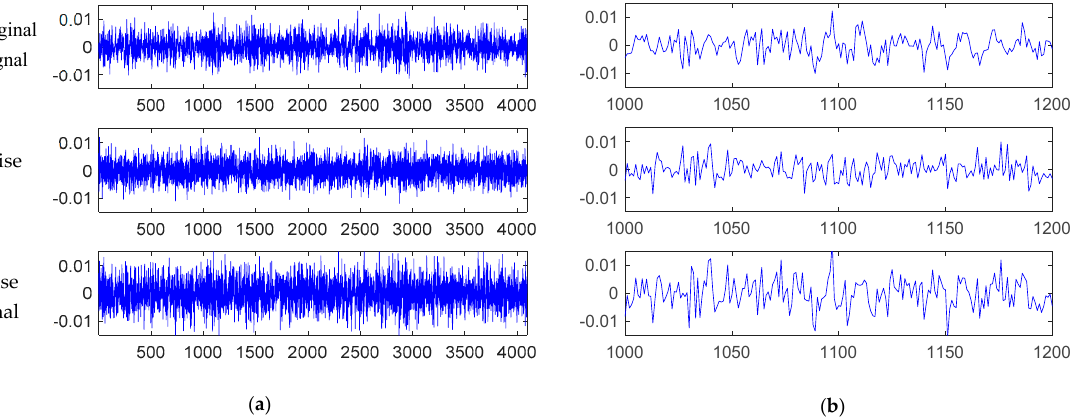
Figure 8. Illustration of the original signal of bolt 2 loosening fault with white Gaussian noise. The composite noise signal with SNR = 0 dB. ( a ) Original signal, Gaussian noise, and noise signal; ( b ) Zoom in the three signals to the range [1000, 1200].